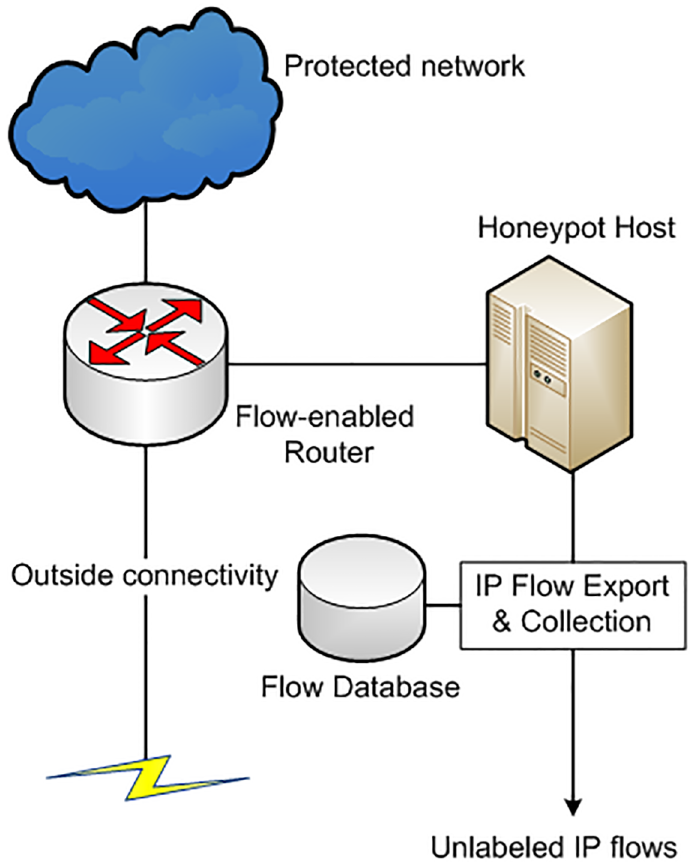
Fig 4. Malicious flow collection